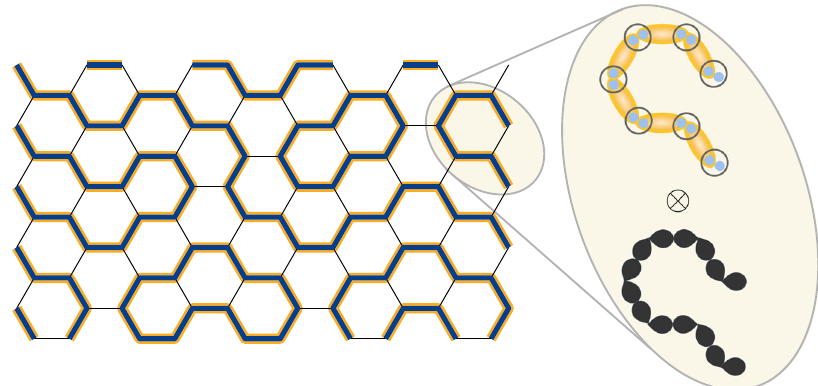
Fig. 1 Pictorial representations of a (static) loop and orbital con fi guration. An orbital and Haldane loop covering a section of the honeycomb